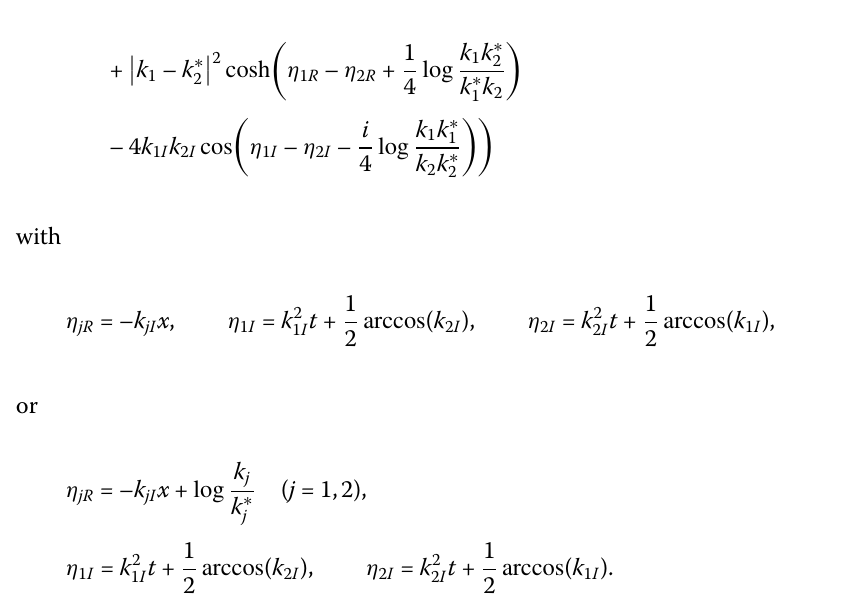
arccos k 2 I , η 20 I = 1 arccos k 1 I . Pictures ( c ) 2 2 , η 10 I = 1 arccos k 2 I , η 20 I = 1 arccos k 1 I . Here 2 2 k ∗ j